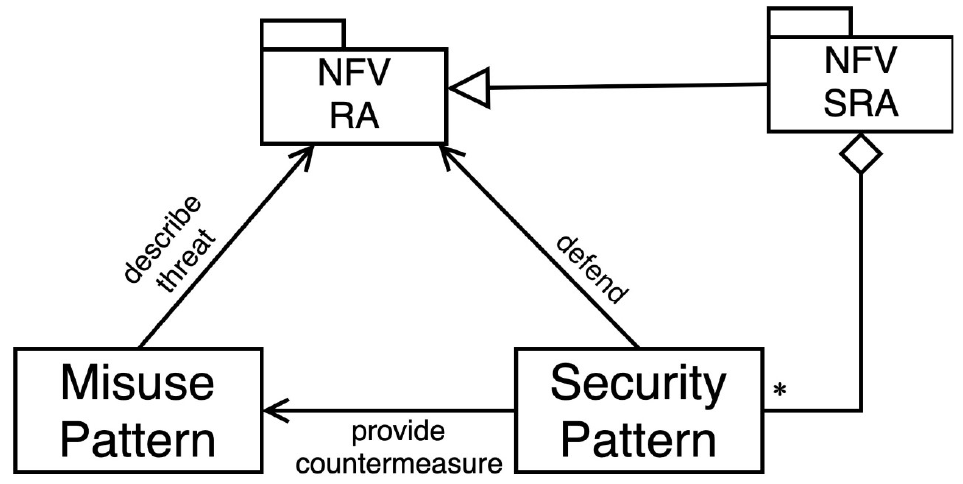
Figure 2. Pattern diagram for the NFV SRA .